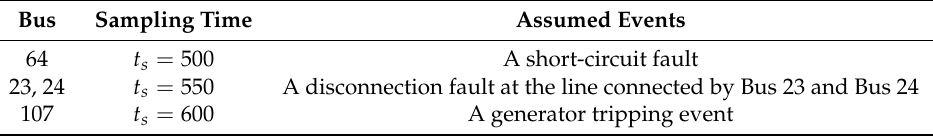
Table 4. A multiple event with three constituent components assumed in Case 3.